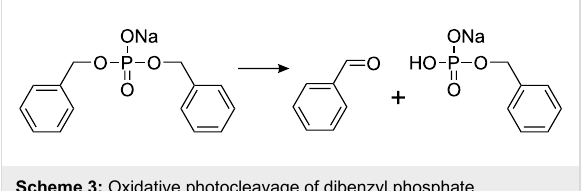
Scheme 3: Oxidative photocleavage of dibenzyl phosphate.